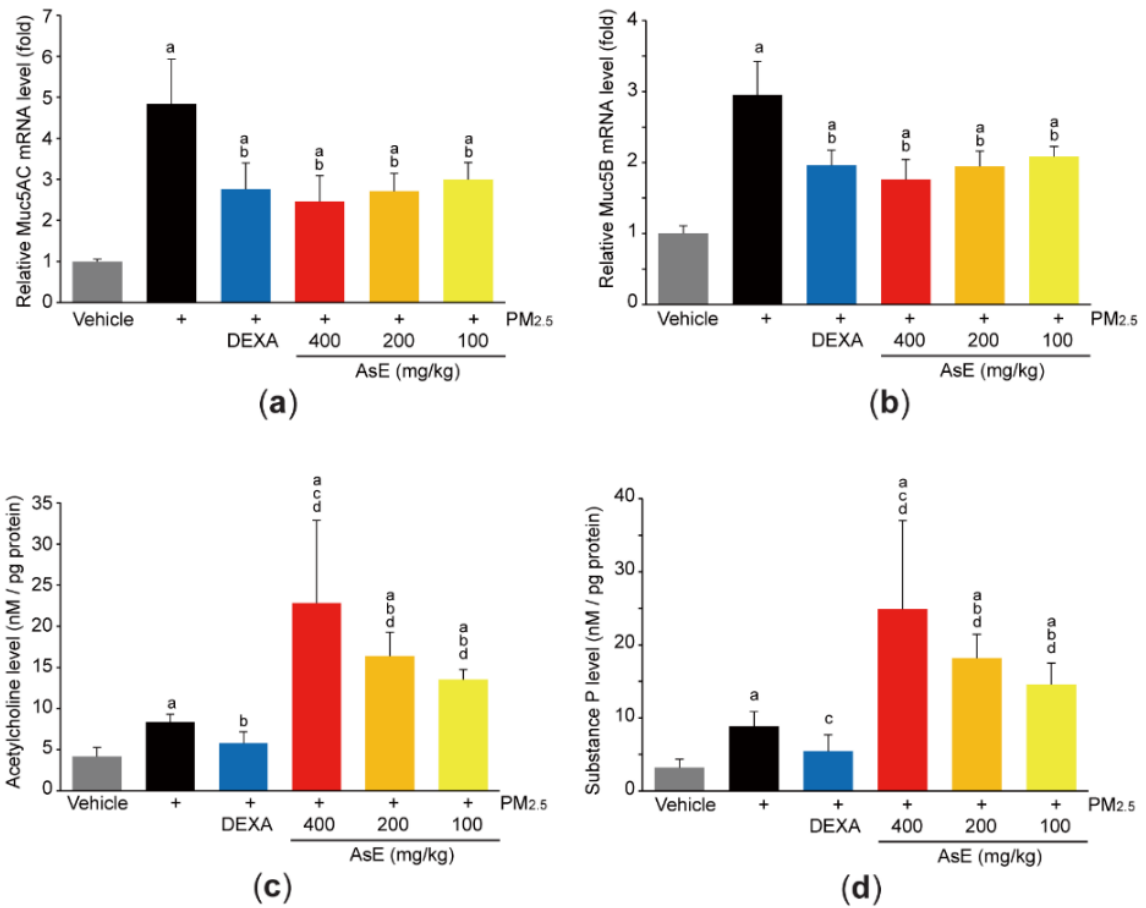
Figure 4. AsE inhibits mucus stasis. ( a , b ) Expression level of Muc5AC ( a ) and Muc5B ( b ) in the left lung lobes was quantified by qPCR. ( c , d ) Levels of acetylcholine ( c ) and substance P ( d ) in the lower right lobes were determined by ELISA. a p < 0.01 versus vehicle group; b p < 0.01, c p < 0.05 versus PM 2.5 group; d p < 0.01 versus PM 2.5 + DEXA group; Muc, mucin.